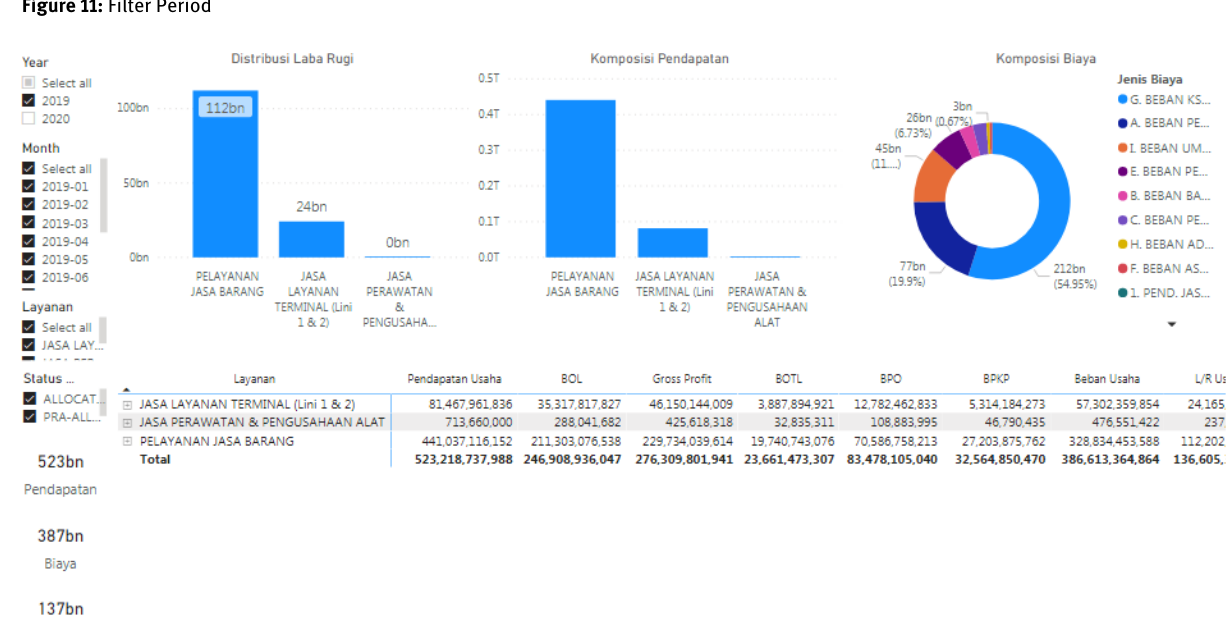
Figure 12: Cost Accounting Dashboard based on Services